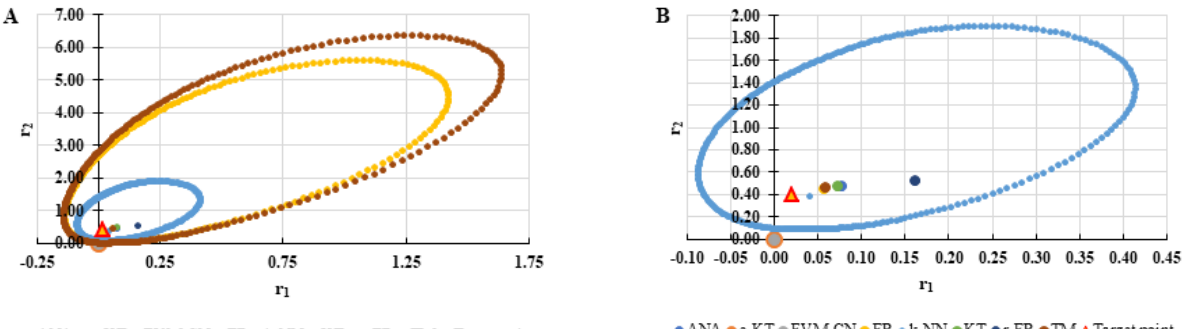
Figure 15. The JCR of analyzed methods for reactivity ratios calculation for MC3 imposed condition ( A ) and detail of smallest JCR with distribution of reactivity ratios ( B ).